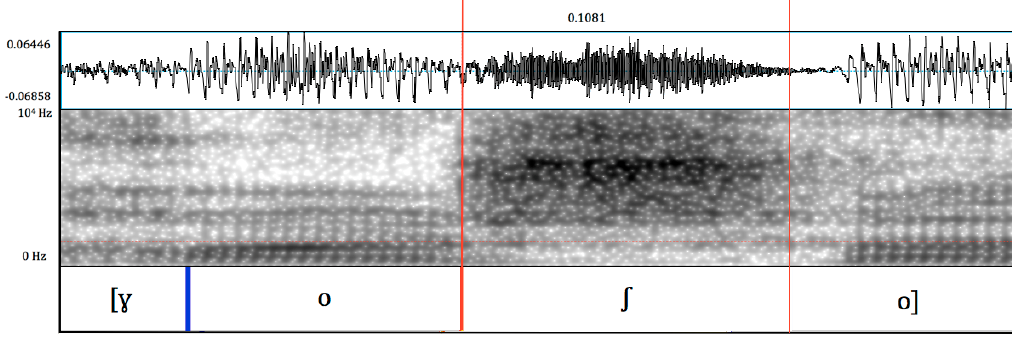
Figure 3. Waveform and spectrogram of the sibilant in the word goxo ‘tasty’.